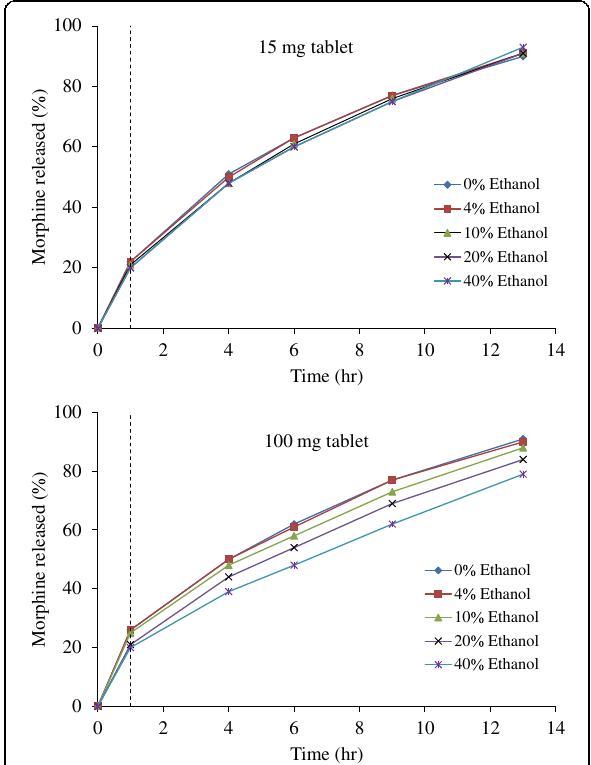
Fig. 10 Morphine sulfate release over time from SR tablets in ethanol ( dotted line indicates a change from acid to buffered conditions) (data from reference (Barkin et al.